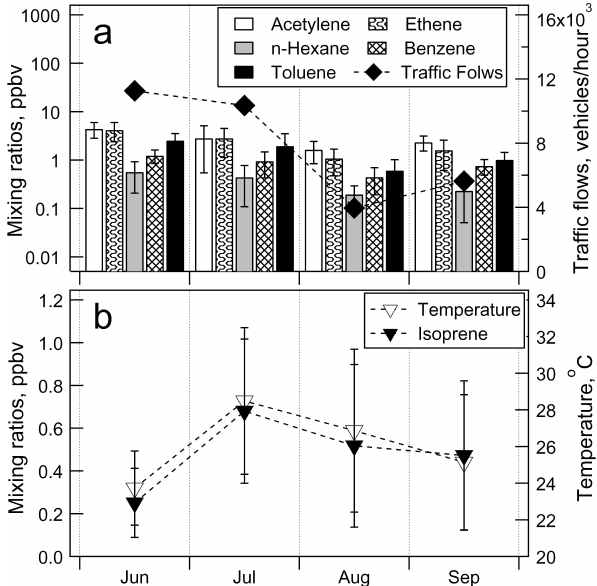
Fig. 3. Associations (a) between the mixing ratios of five NMHC tracers and number of vehicles and (b) between the mixing ratios of isoprene and temperature from June to September at PKU